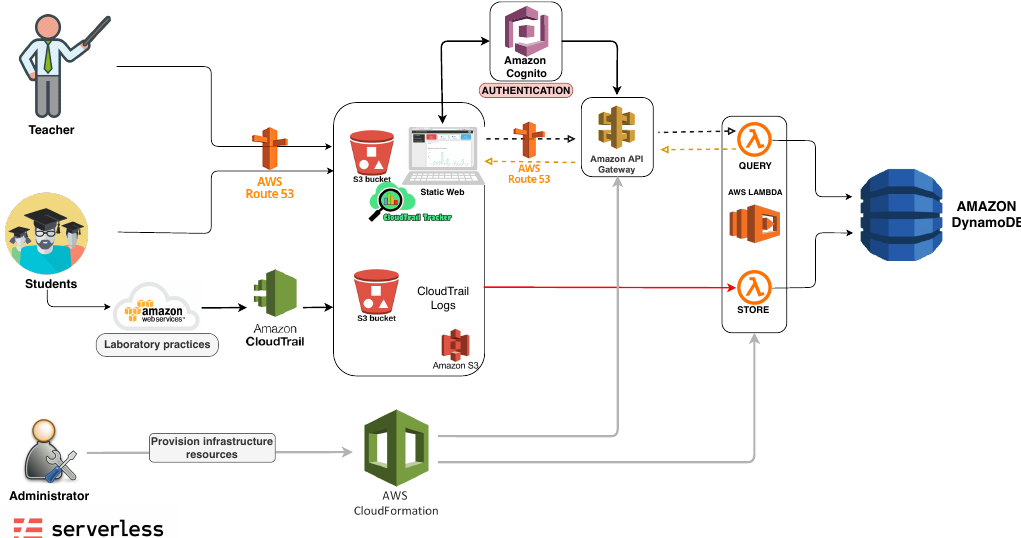
Figure 2. Distributed platform to collect, store, process, and visualize educational analytics for cloud training in Amazon Web Services